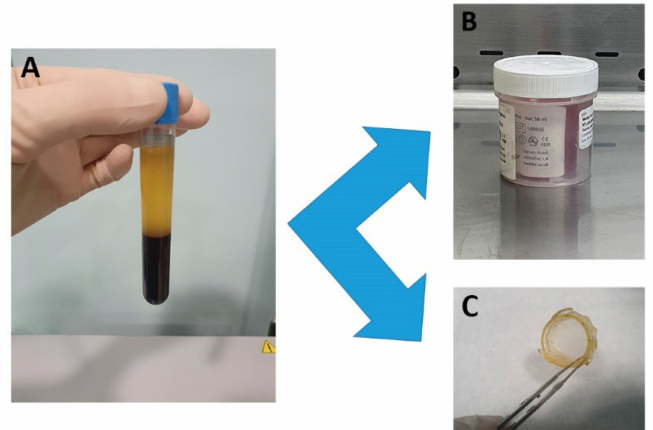
Figure 1. Human plasma ( A ) is used both as supplement (PRGF) for the culture medium ( B ) and as a scaffold (PRGF membrane) ( C ) for culturing and delivering LSC. PRGF: Plasma Rich in Growth Factors; LSC: Limbal Stem